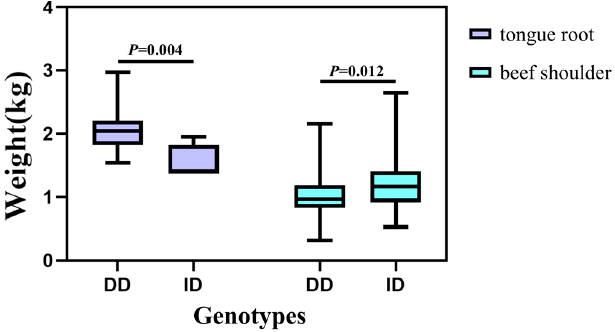
Figure 10. Association of the P1-Ins-4-bp InDel with carcass traits in the female SDBCGR popula-